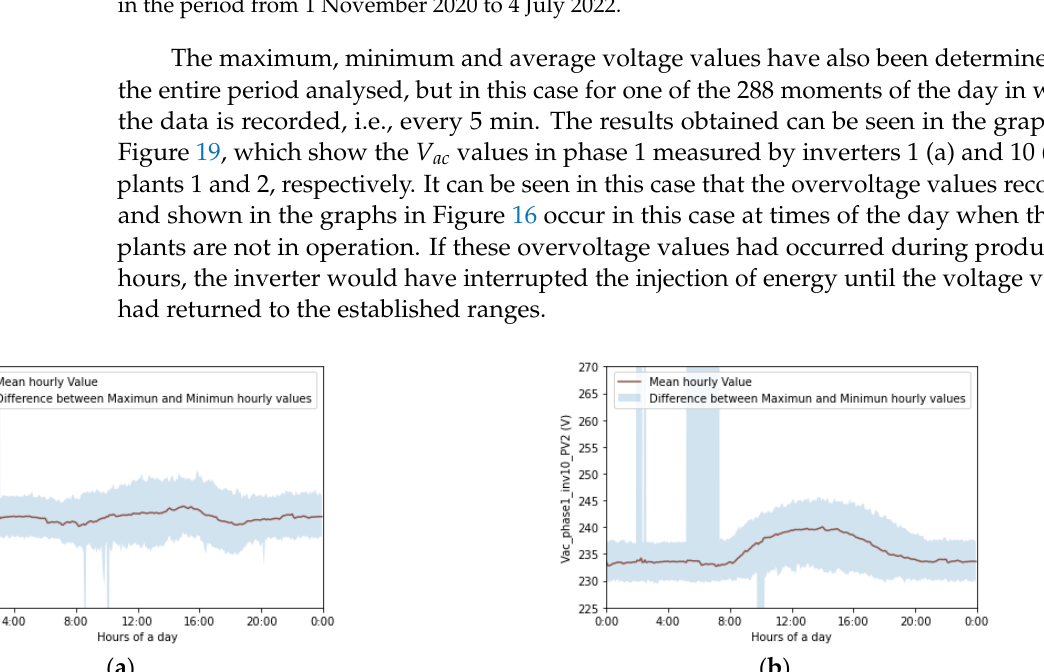
Figure 18. Average values (brown) and the difference between daily maximum and minimum (blue) of the V ac grid voltage measured on phase 1 by inverter 1 of plant 1 ( a ) and inverter 10 of plant 2 ( b ), in the period from 1 November 2020 to 4 July 2022.